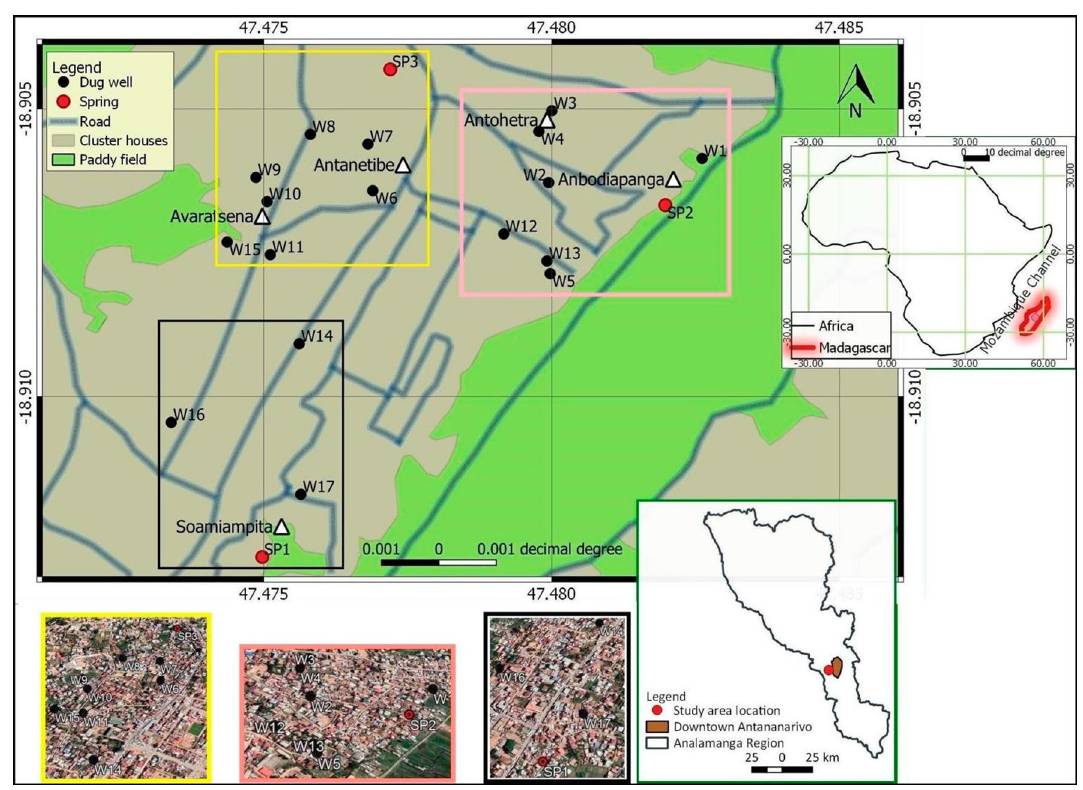
Fig. 1 Study area location, at regional and local scale. Details of the cluster houses, where the samples were collected are shown using satellite imagery. Sampling sites are also displayed. Source : Google Earth, georeferenced and digitized using QGIS 2.14